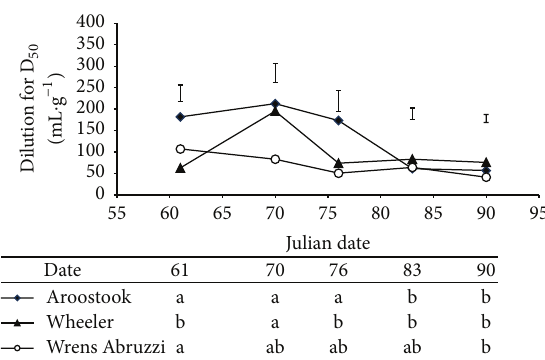
Figure 4: Inhibition of ryegrass germination and growth by extracts of three field grown rye varieties, harvested at five different dates (Julian dates) during the spring of the second year of experiments. D 50 is the concentration required to cause 50% growth inhibition. Values associated with the same letter are not significantly different according to the Tukey-Kramer method ( 𝑝 < 0.05 ). Vertical bars represent standard errors at each sampling